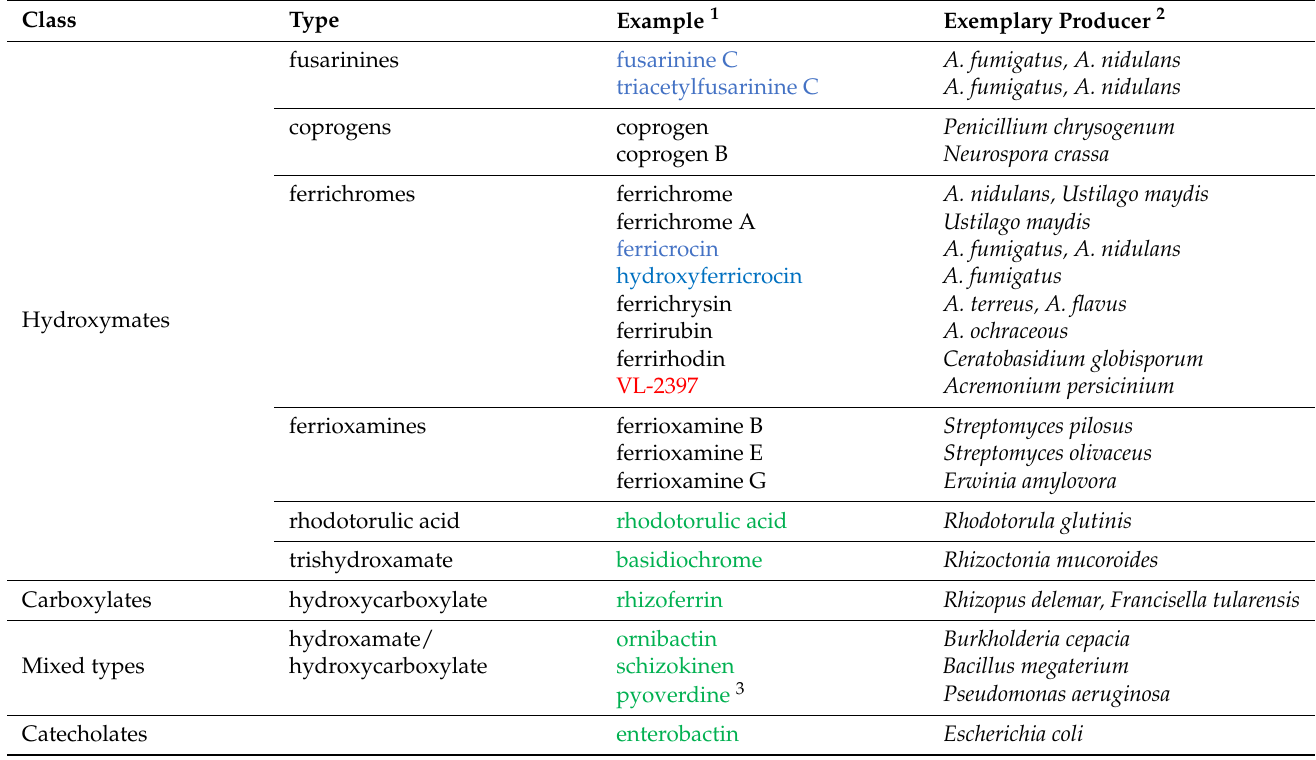
Table 1. Siderophores used or discussed in this study